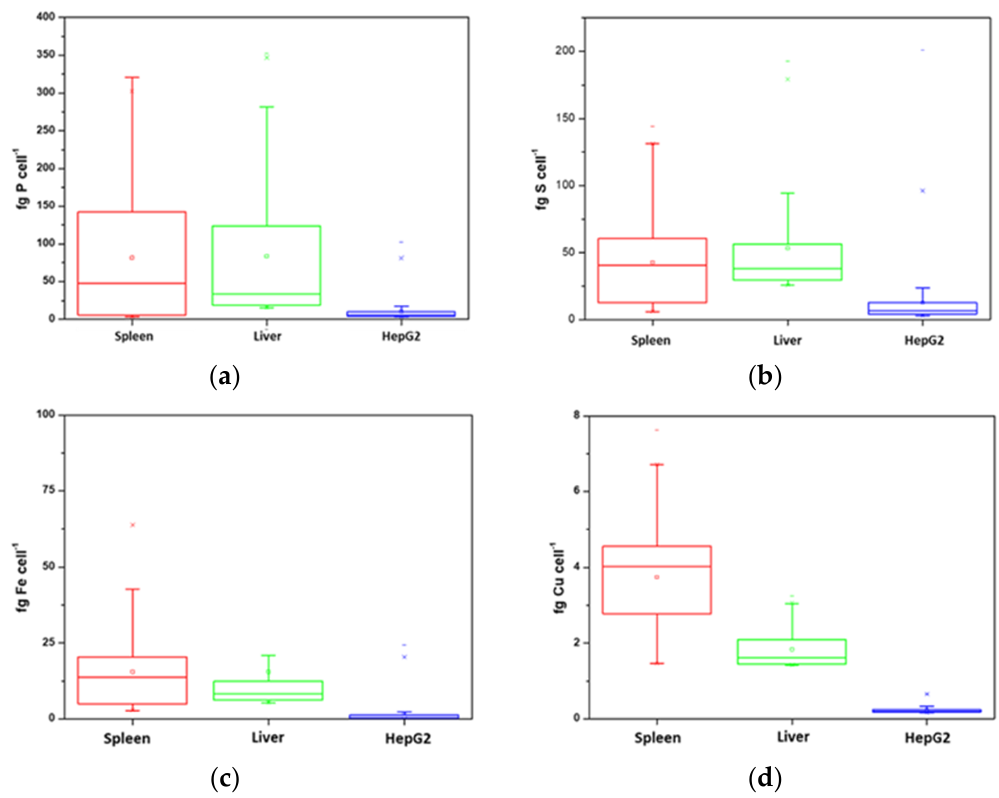
Figure 4. Boxplots showing the mass per cell of ( a ) phosphorus, ( b ) sulfur, ( c ) iron, and ( d ) copper in spleen (red), liver (green), and HepG2 (blue) cells.